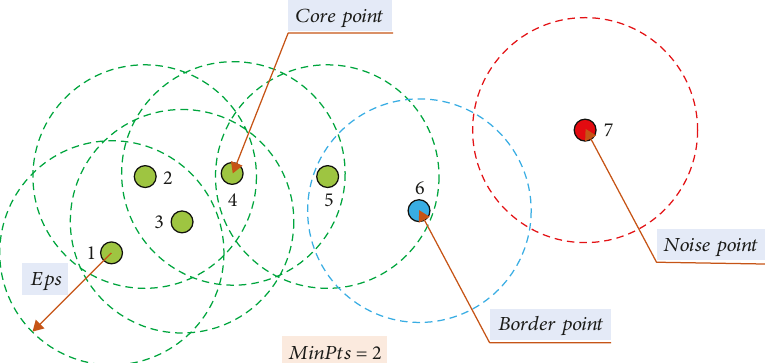
Figure 5: Illustration of the DBSCAN algorithm.